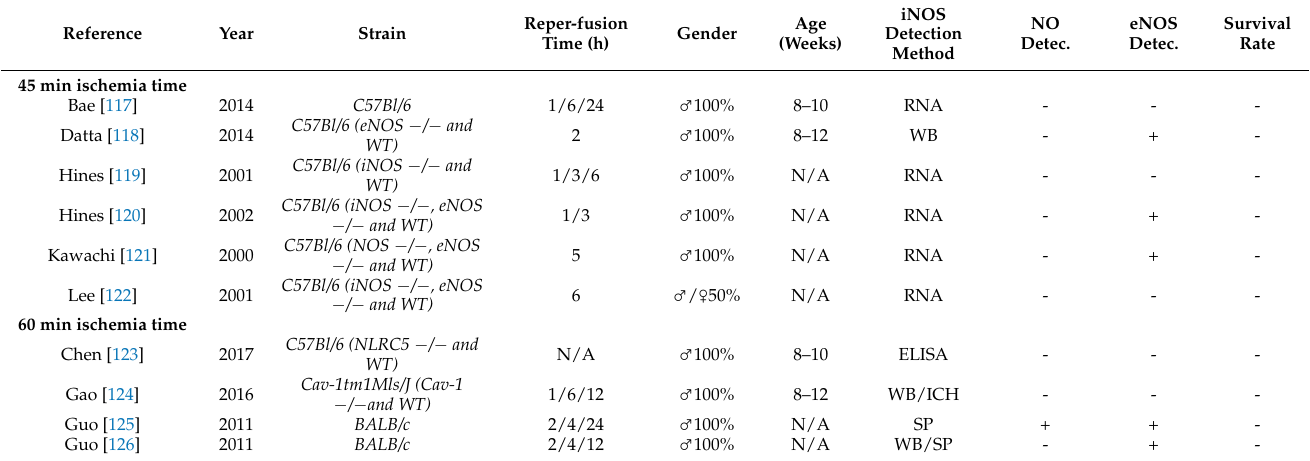
Table 4. Overview of mouse models with 70%